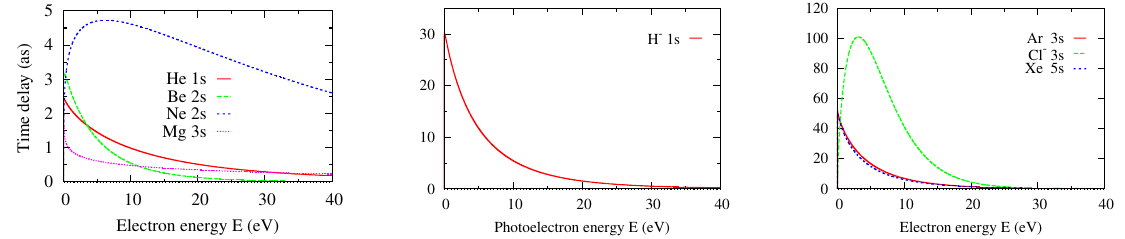
Figure 3. Shake-off time delay (in attoseconds) in He 1 s , Be 2 s , Ne 2 s and Mg 3 s ( left ), hydrogen H − 1 s ( center ) and Ar 3 s , Cl − 3 s and Xe 5 s ( right ), calculated by taking the energy derivative of the SO phase Equation